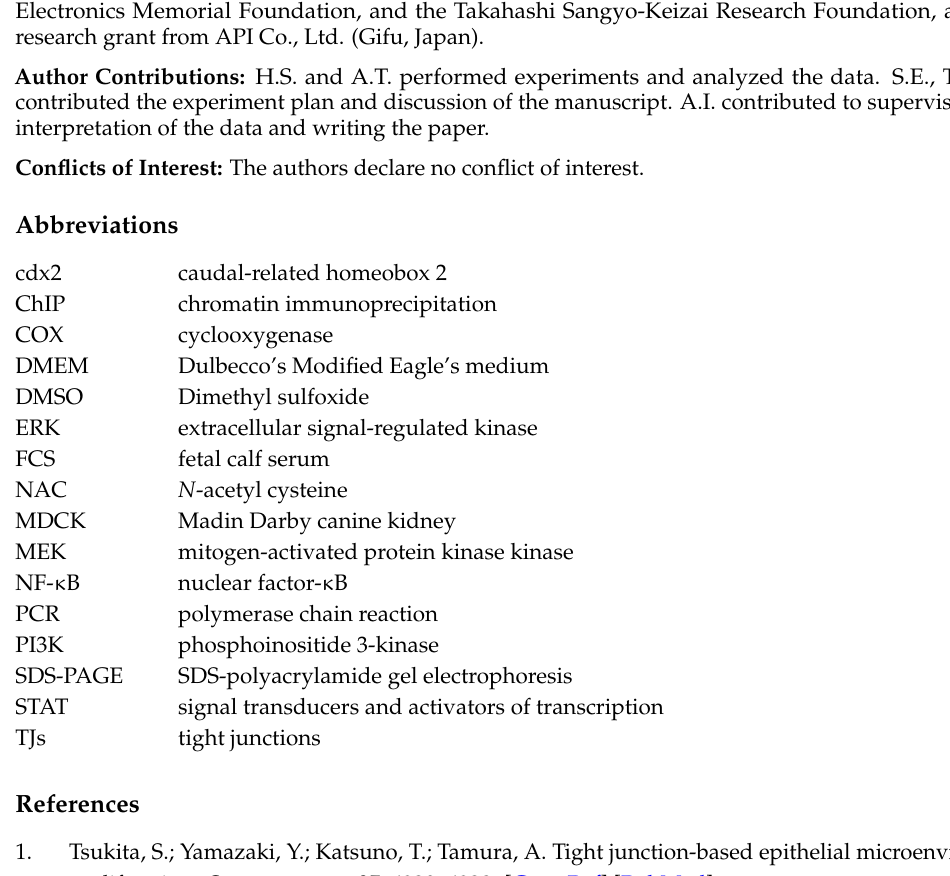
Figure S1: Effects of flavonoids on cell